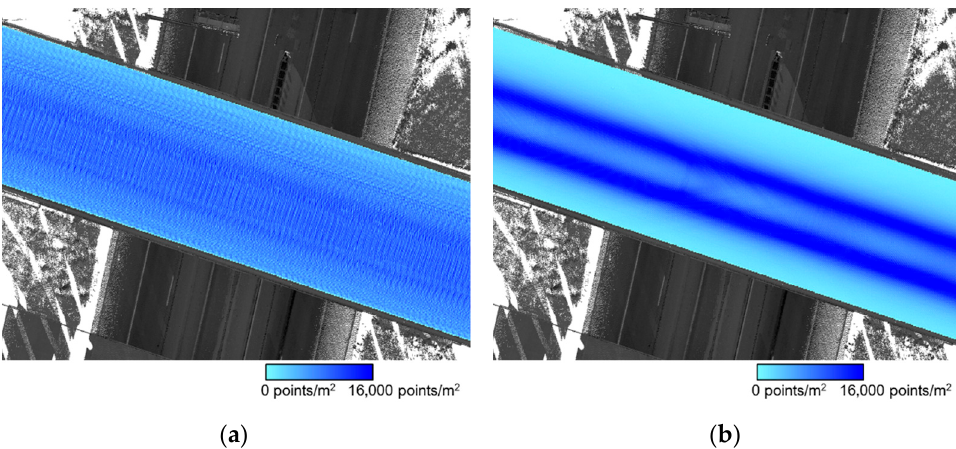
Figure 12. Point density over the bridge deck from one track (track T1) for: ( a ) PWMMS-HA and ( b ) PWMMS-UHA. ( b )